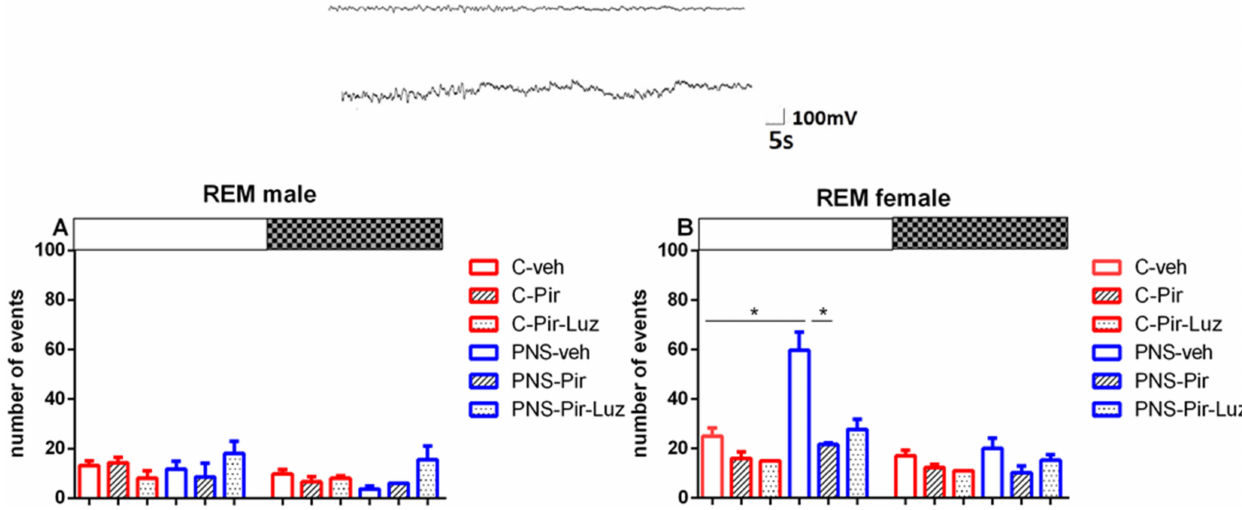
Figure 9. Representative EEG (frontal cortex) and EMG (neck muscle) recording during REM sleep of control. Diurnal rhythm of REM number of events in male ( A ) and female rats ( B ) during the Light and the Dark phase, indicated by open and black rectangles above the figure, over a 24-h recording for C-veh, C-Pir, C-Pir-Luz, PNS-veh, PNS-Pir and PNS-Pir-Luz group. * p < 0.05 vs. C-veh or PNS-veh group,